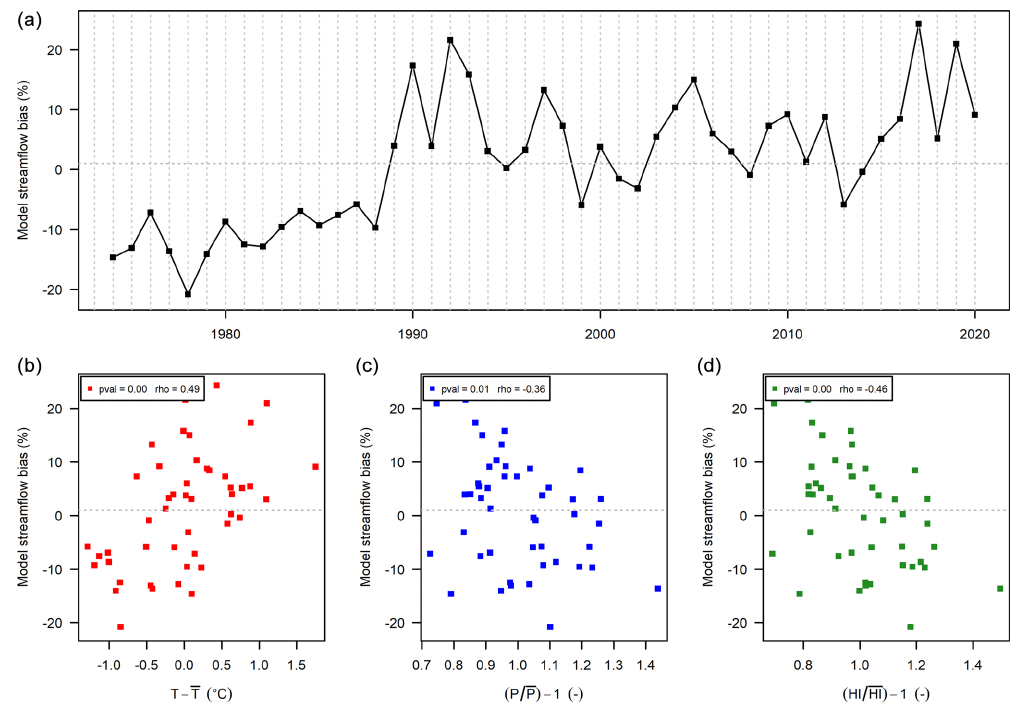
Figure 7. Streamflow annual bias obtained with the RAT function of time (a) , temperature absolute anomalies (b) , and precipitation P (c) and humidity index P/E 0 (d) anomalies, for the Arroux River at Étang-sur-Arroux (K1321810) (1790km 2 ).